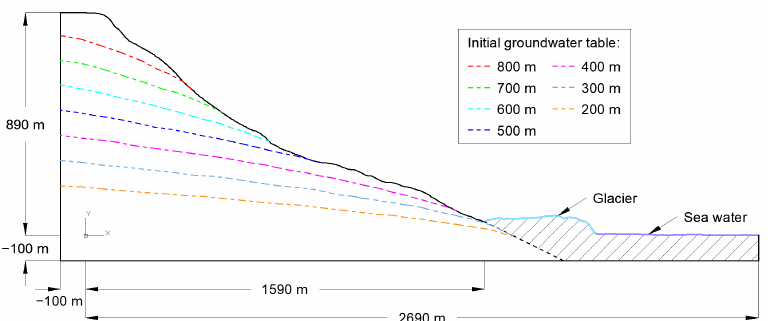
Figure 6. Different groundwater tables in the calculation based on the 2014 slope